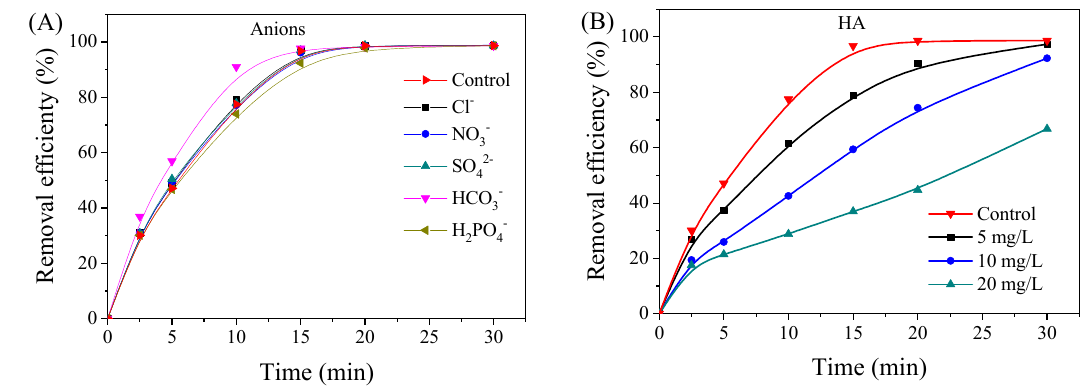
Figure 4. E ff ects of di ff erent anions ( A ) and humic acid (HA) concentrations ( B ) on the removal Figure 4. Effects of different anions ( A ) and humic acid (HA) concentrations ( B ) on the removal e ffi ciency of Et-PABA. Conditions: [Et-PABA] = 0.05 mM, [anion] = 5 mM, [HA] = 5–20 mg / L, [PDS] = efficiency of Et-PABA. Conditions: [Et-PABA] = 0.05 mM, [anion] = 5 mM, [HA] = 5-20 mg/L, [PDS] = 2.0 mM, and without pH 2.0 mM, and without pH adjustment.